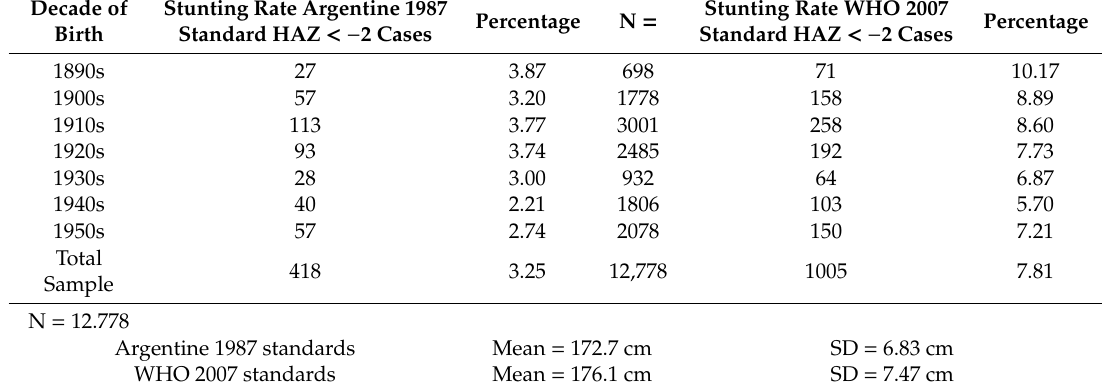
Table 5. Stunting rates by decade Inmates of Buenos Aires prisons b.1885–1959.